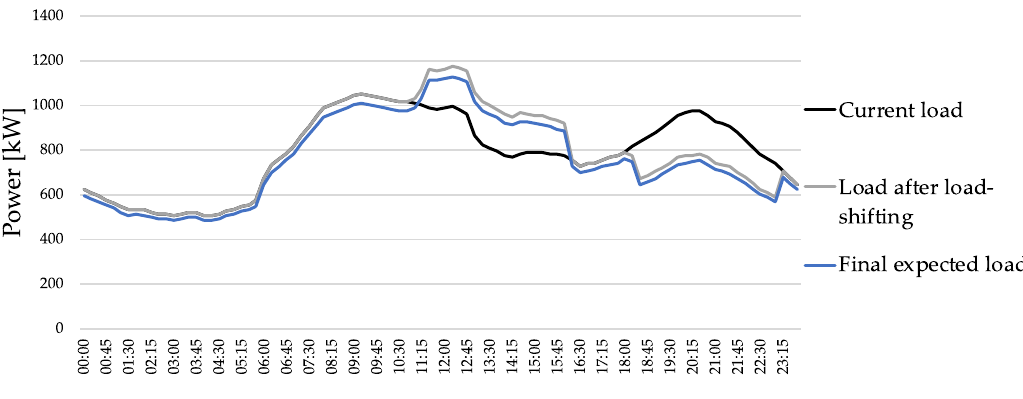
Figure 3. Load-shifting effect.